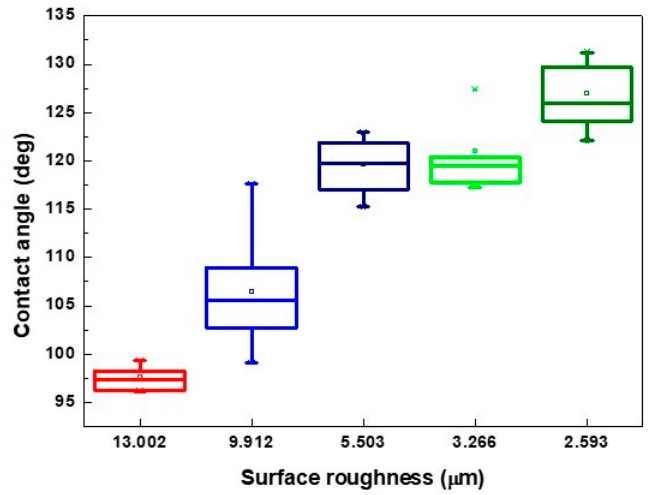
Figure 10. Contact angle of physiological saline droplet on the XO RGP contact lens with five surface roughness under laser scanning speed of 500 mm/s.